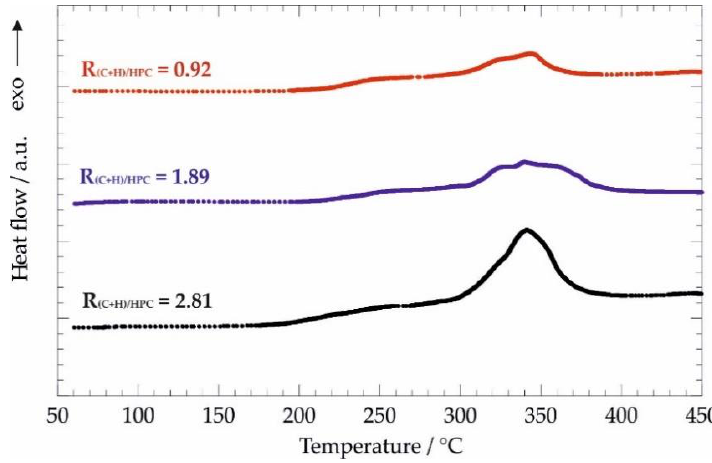
Figure 5. The differential scanning calorimetry (DSC) curves for nanocomposites at variable compositions.